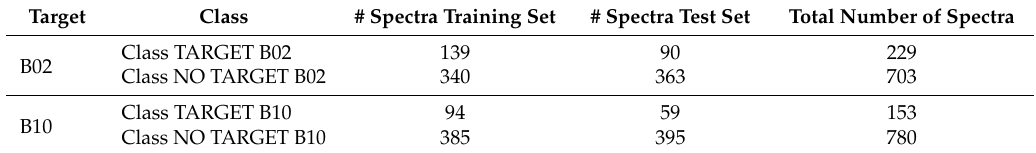
Table 5. Composition of the QEPAS dataset for target B02 and target B10 classification model